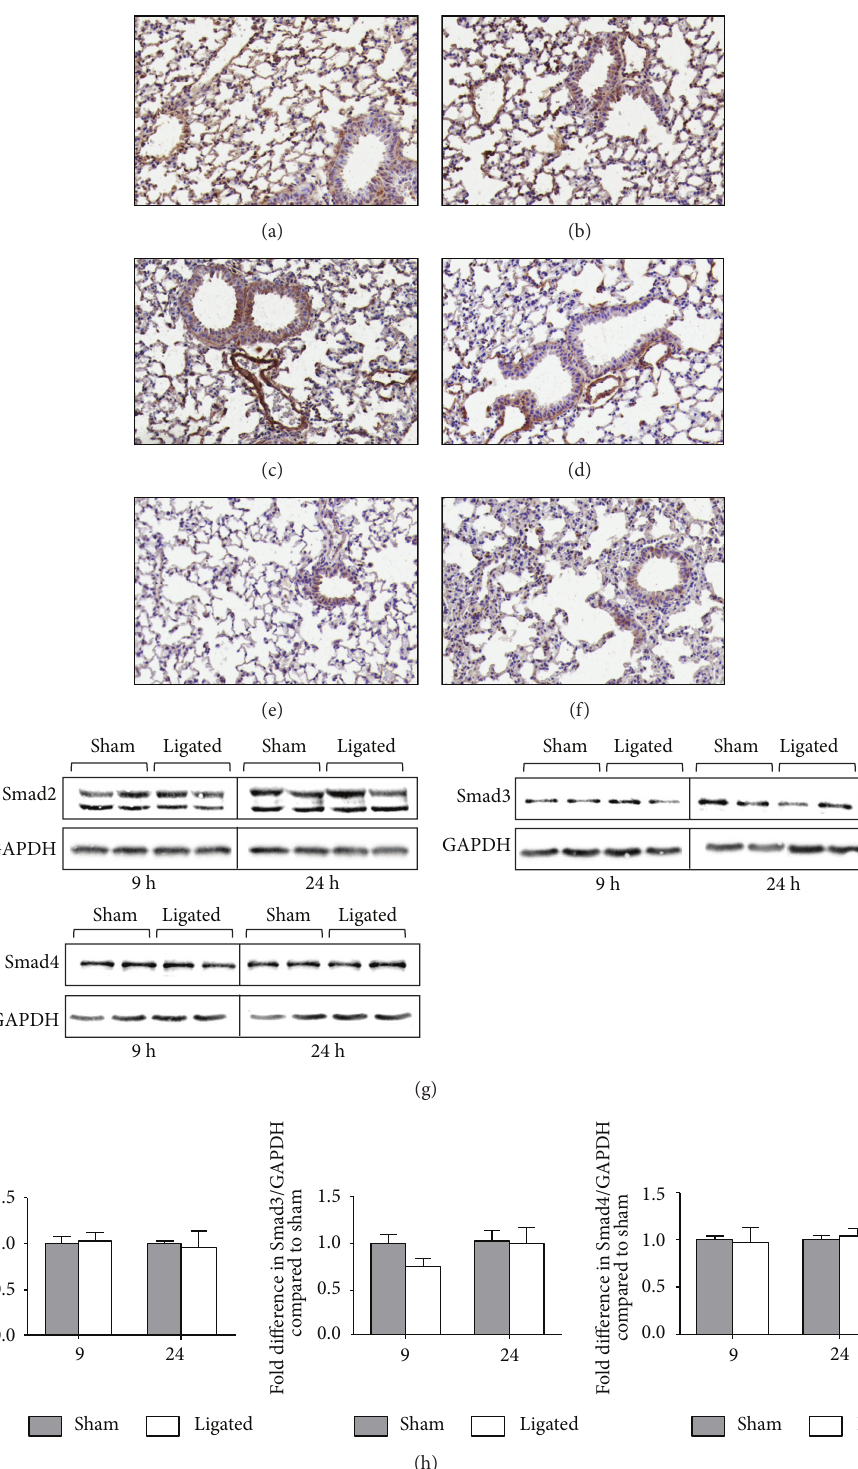
Figure 3: Distribution of Smad proteins in the lungs. Immunostaining of Smad2 (a and b), Smad3 (c and d), and Smad4 (e and f) levels in lung tissue at 9 h from sham controls (a, c, and e) and acute pancreatitis groups (b, d, and f). Results from one representative of eight samples per group are shown. Original magnification, × 20. Western blot analysis of Smad2, Smad3, and Smad4 protein levels in lung extracts of sham- operated and ligated animals at the indicated time points (g). Two of five similar analyses per group are shown. Graphs show densitometry measurements of fold difference in Smad2, Smad3, and Smad4 levels compared to sham control and represent mean ± SEM of five samples per group